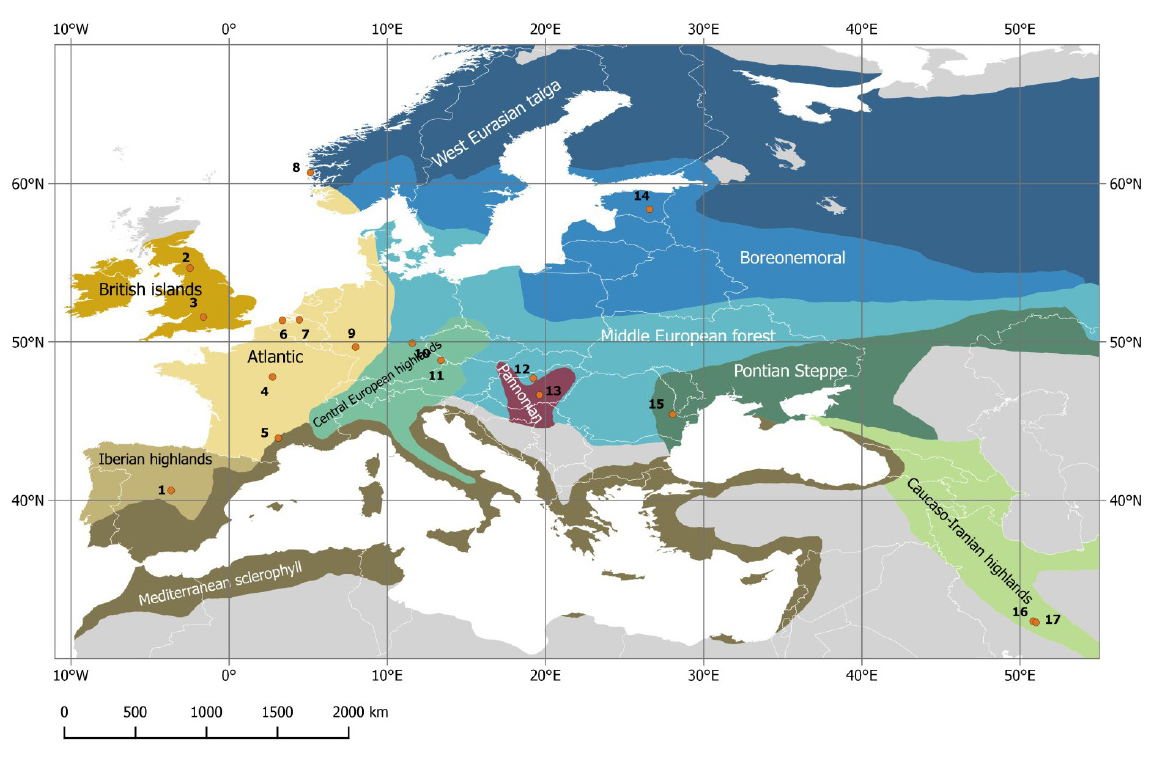
Figure 1. Dung beetle sampling locations in the ALTER-Net MSE III experiment, and their position within biogeographic provinces (as defined by Udvardy (1975); the digital base map was adapted from FAO Geonetwork (2015)). Names and exact locations of the study sites are given in Table